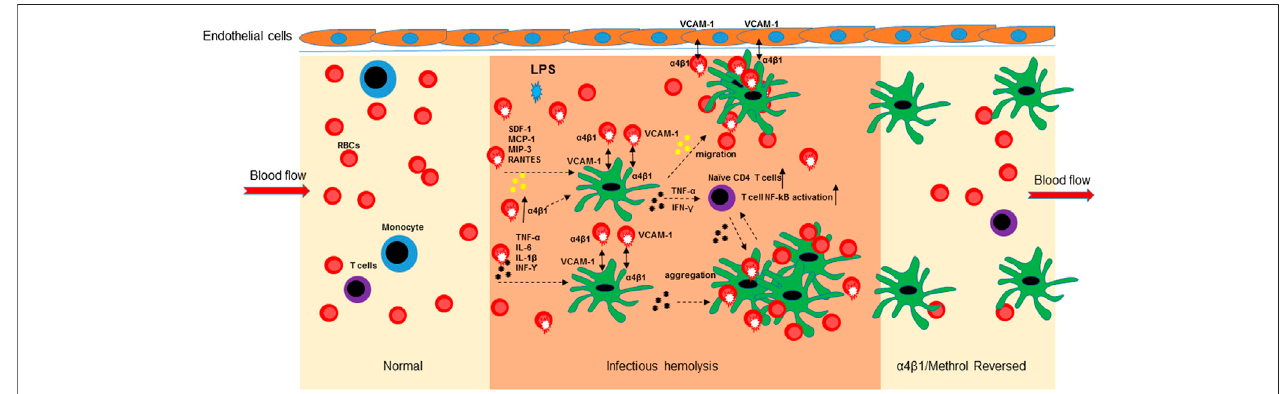
FIGURE6| Schematic diagram ofthe α 4 β 1/Methrol reversing dendritic cell dysfunctionin LPS-induced hemolysis. LPS-induced hemolysis resultedin an increase of integrin α 4 β 1 expression on RBCs that subsequently mediated cell-cell aggregation, released cytokines/chemokines and evoked immune cell responses. LPS increasedintegrin α 4 β 1expressiontofacilitatecell-cellinteractionofRBCs/mo-DCs, RBCs/HLMVEC,andRBCs/mo-DCs/HLMVEC.CellaggregationofRBCsandmo- DCsfurtherenhancedcytokinesreleaseandactivationofNF-kBpathwayinimmuneTcells.Chemokines/cytokinesinducedmo-DCsmigrationtoHLMVEC. α 4 β 1/ VCAM-1isaninterconnectivemoleculeforRBCs,mo-DCs,andHLMVECaggregationatin fl amedsite. α 4 β 1/Methrolblockedcellaggregation,decreasescellmigration, protected the RBCs from hemolysis caused by LPS, as well as upregulated GILZ expression culminating in reversing the dysfunction of the immune cells, in particular dendritic cells.